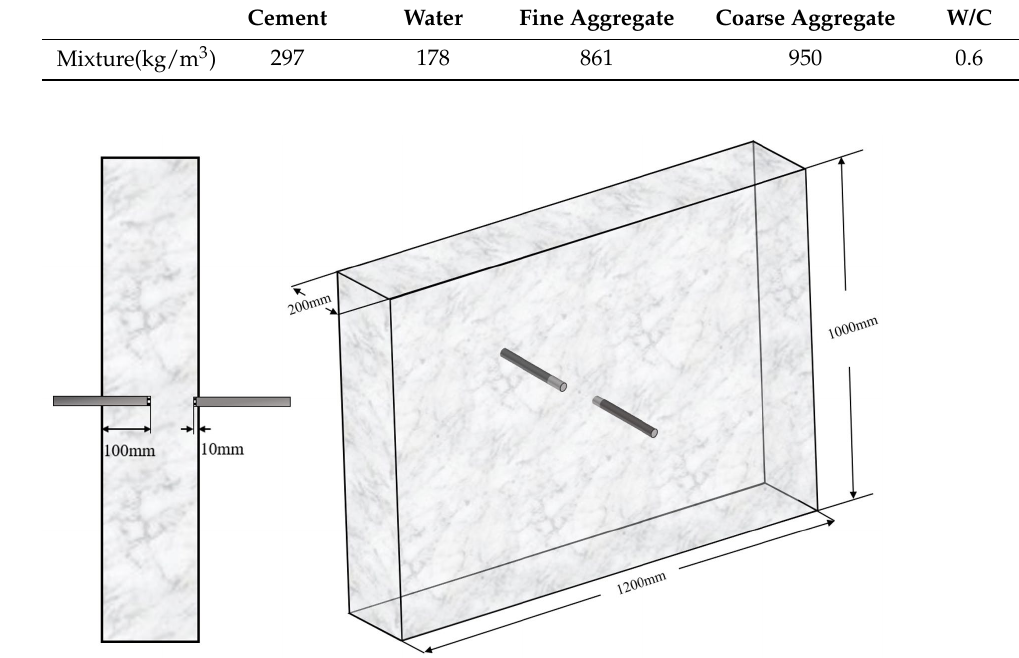
Figure 3. Concrete specimen and setup for temperature sensors [24]. Table 1. Concrete mix proportion [24].